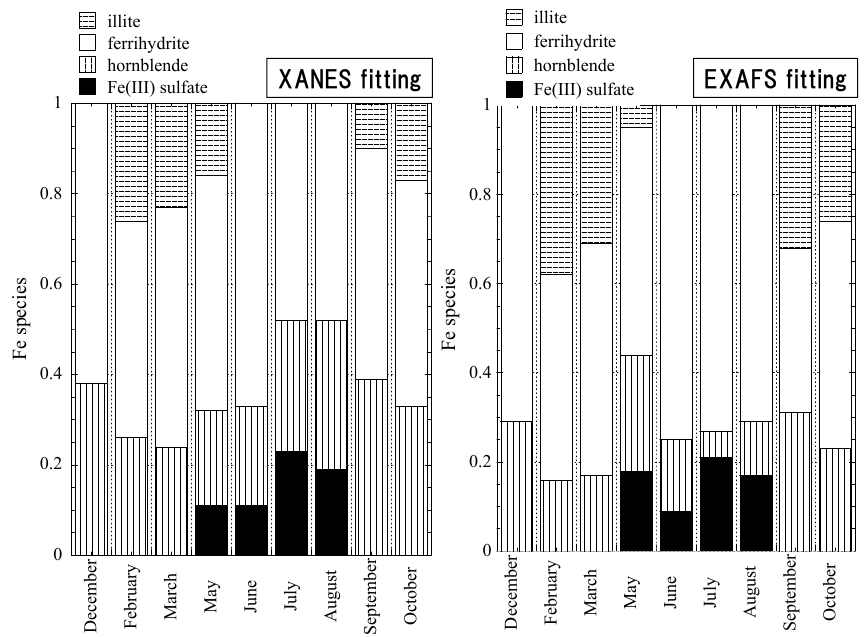
Fig. 6. Iron species in aerosols estimated by (a) XANES fitting and (b) EXAFS fitting.